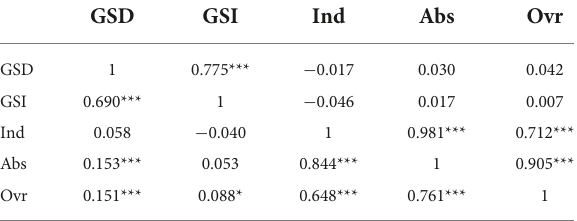
CorrelationsabovethediagonalstemfromtheGermansample,thosebelowthediagonal stem from the English sample. N = 1517 (German sample) and 1539 (English sample). GSD, global self-definition; GSI, global self-investment; Ind, indifference; Abs, abuse; Ovr,over-control.* p < 0.05.*** p <